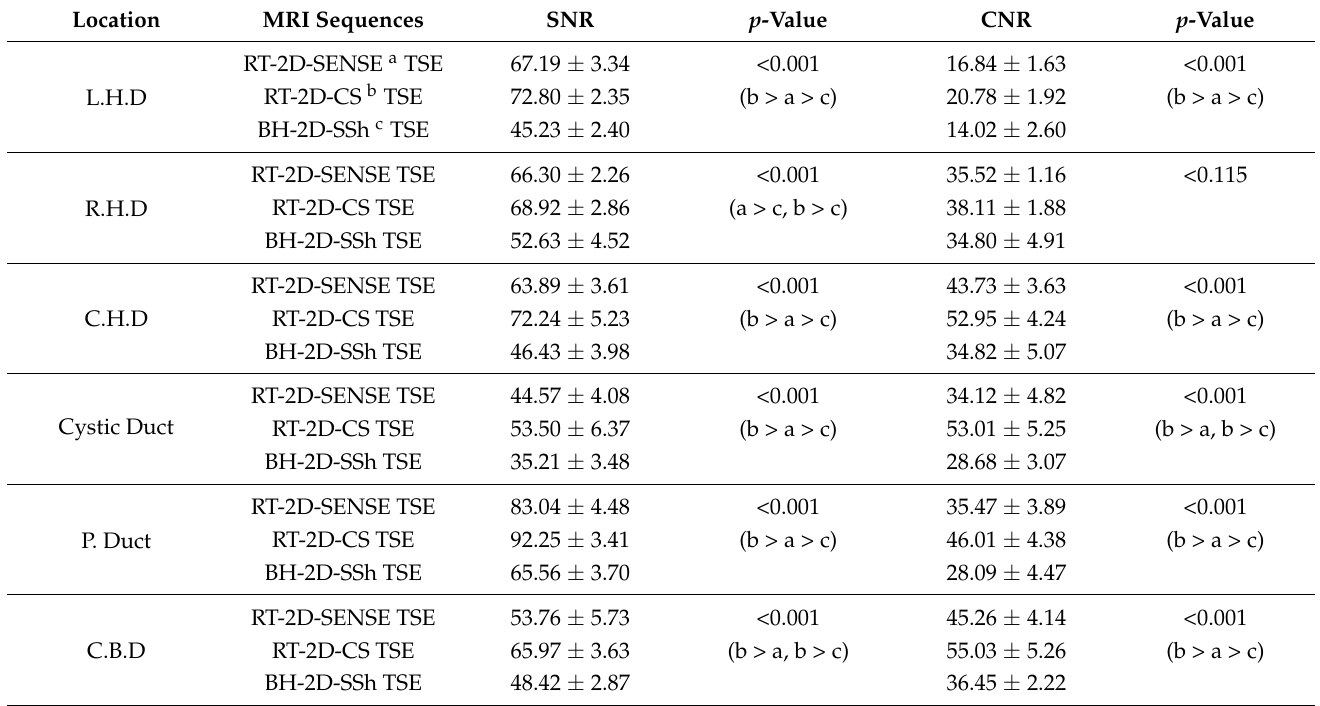
Table 2. SNRs and CNRs values in Volunteer’s MRCP Images ( n = 10, 60 cases). Location